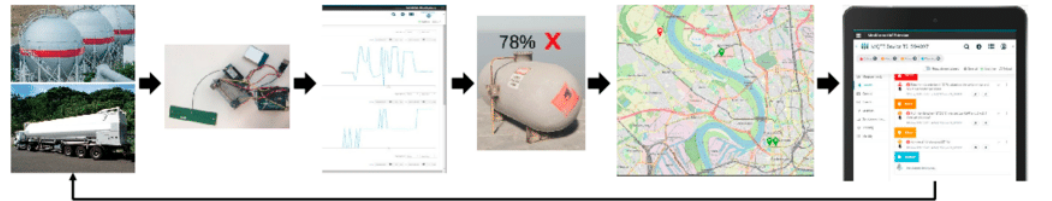
Figure 37. A digital twin for safety and risk management: a hydrogen high-pressure vessel case [136].